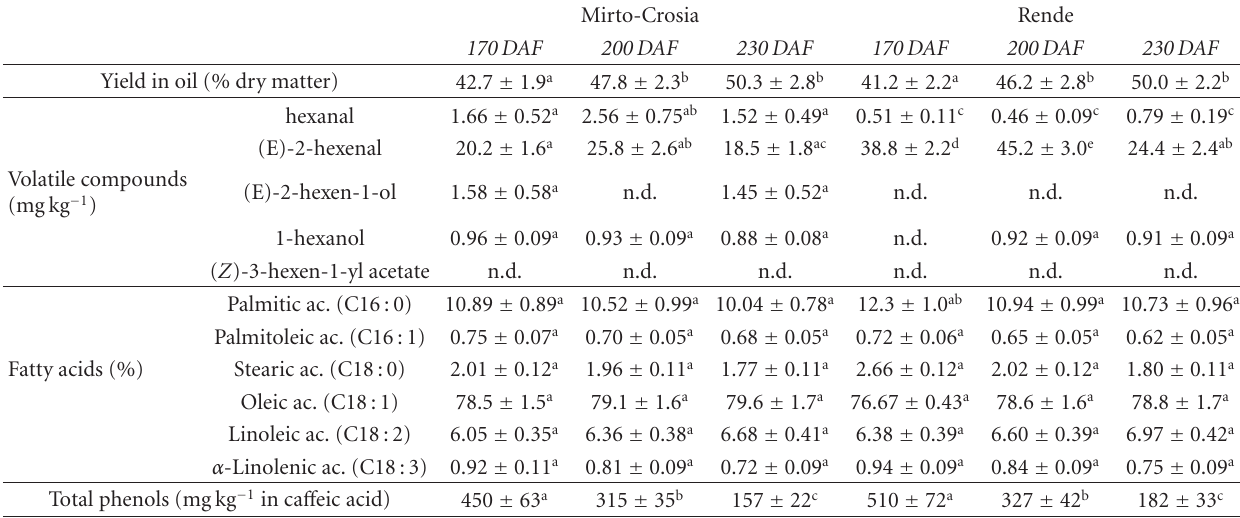
Table 2: Virgin olive oil quality indices from “Coratina” cv after malaxation ( t = 30 min). The yield in oil (in % on dry matter), the content of volatile biomarkers (in mgkg − 1 oil), the main fatty acids (in %), and the total phenols (in mg kg − 1 in ca ff eic acid) are reported. The drupes were collected at three developmental stage of ripening (170 days after flowering DAF = green mature; 200DAF = black with < 50% purple flesh; 230 DAF = black with > 50% purple flesh) and in two di ff erent cultivation areas (Rende and Mirto-Crosia). Data are expressed as mean values ± standard deviation of three independent experiments. Duncan test has been used to assess significance ( P = 0 . 05). Values followed by di ff erent letters in the same line are significantly di ff erent. n.d.: not detected.